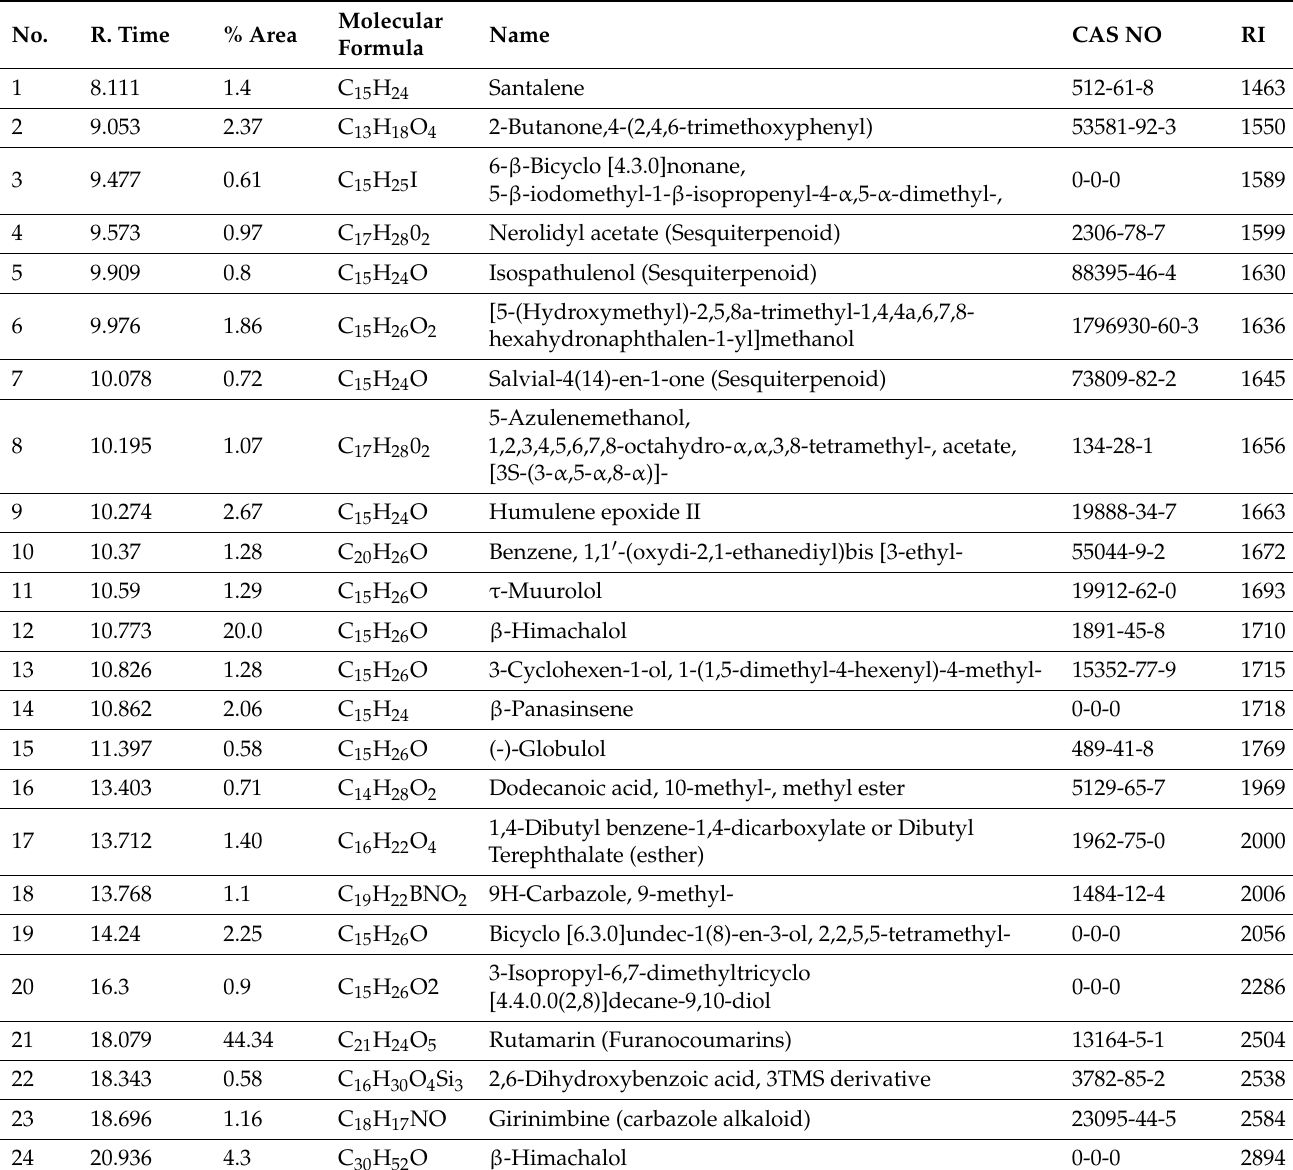
Table 10. Phytocompounds identified in isolated non-volatile oil A from the root bark of T. ciliata by